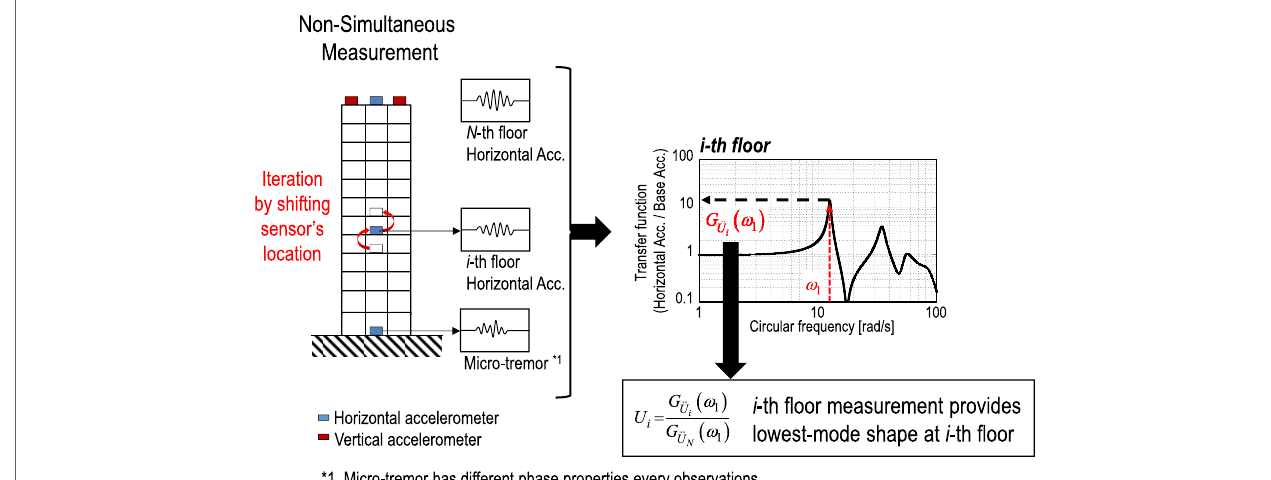
FIGURE 3 | Essential schematic diagram of lowest mode identification in non-simultaneous measurement system.